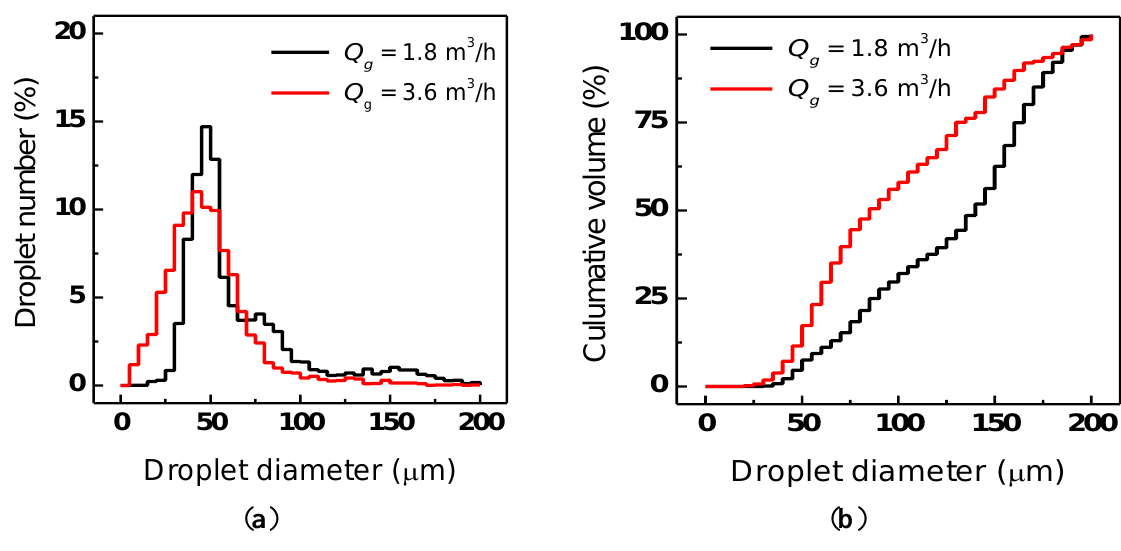
Figure 6. Distributions of size and cumulative volume of water droplets at Q C = 150 ppm and Q w volume distribution.